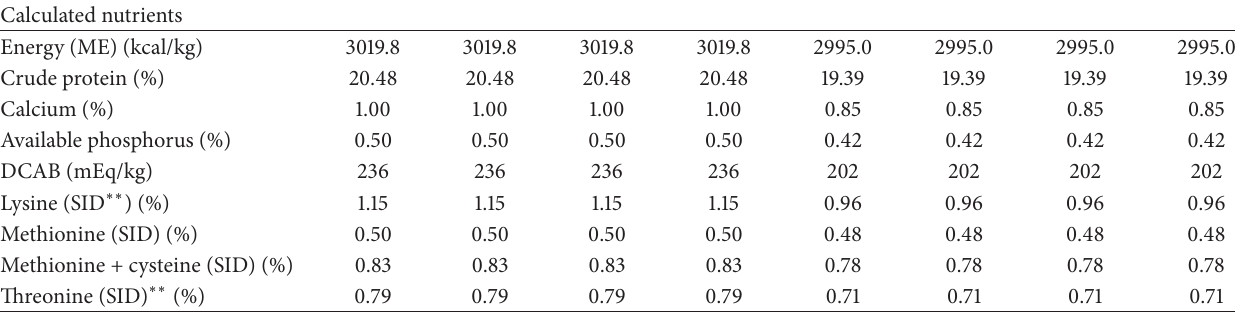
Table 4: Nutrient analysis of diets during the starter (1st–21st days of age) and grower (22nd–42nd days of age) periods. Calculated nutrients Energy (ME)